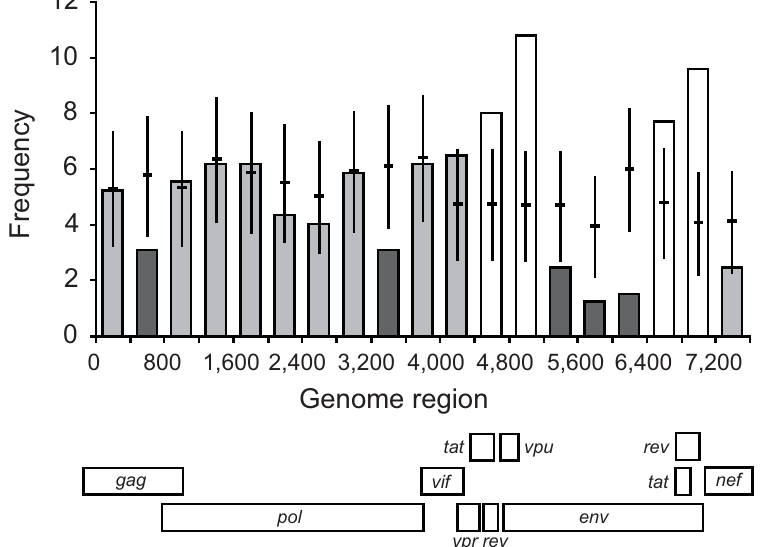
Figure 4. Implementation of the recombination model. Comparison of model-predicted breakpoints (horizontal lines) with breakpoint locations from HIV-1 recombinants (vertical bars) [26] from the HIV Sequence Database. White bars indicate where the number of breakpoints for the global data is significantly higher than the prediction for the region, light grey bars indicate where the global data falls within the prediction, while dark grey indicates where the global data is significantly lower than the model prediction. The error bars on the model-predicted values represent 1.645 6 standard error to include 90% of the distribution. The normalised frequency data ( y -axis) have been divided into bins of size 400 nucleotides ( x -axis). Below the x -axis, the various genomic regions of the HIV-1 genome are displayed. Note, positioning of genes is relative to a gap-stripped sequence alignment.